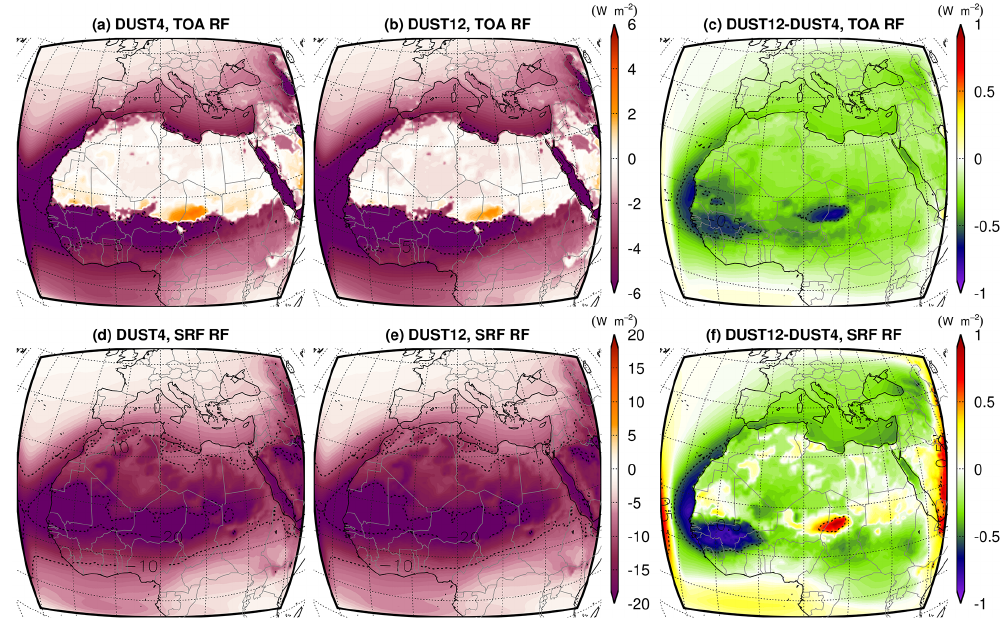
Figure 13. Top-of-the-atmosphere (top) and surface (bottom) radiative forcing in the shortwave spectrum for the period December 2006 to November